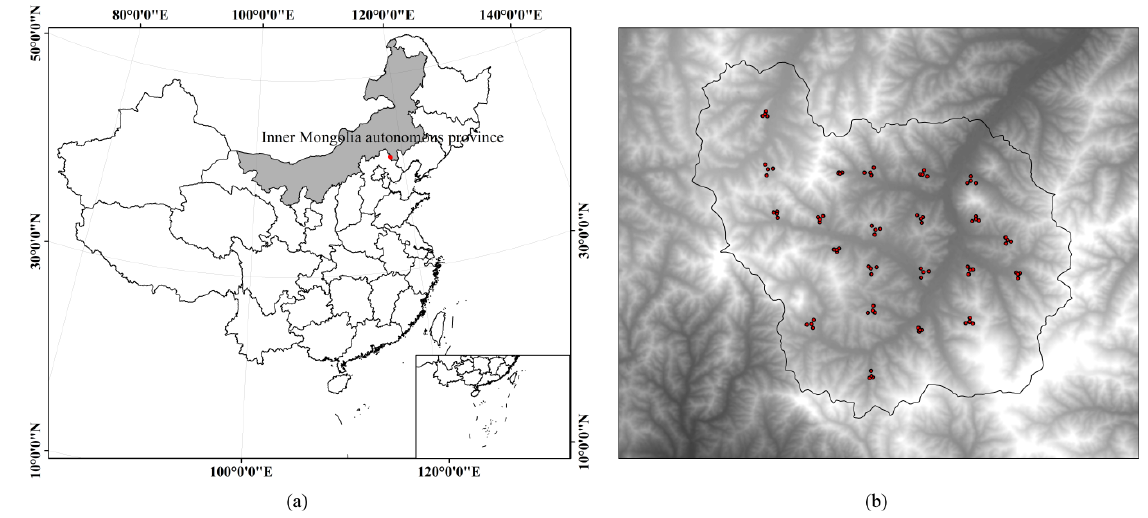
Figure 1. Overview of study area. ( a ) Location of the study site in the Wangyedian forest farm in Inner Mongolia Autonomous Province, China; and ( b ) Spatial distribution of plots (red dots indicate plot centers overlaid on ASTER GDEM of 30 m resolution, the grey line is the boundary of Wangyedian forest farm).